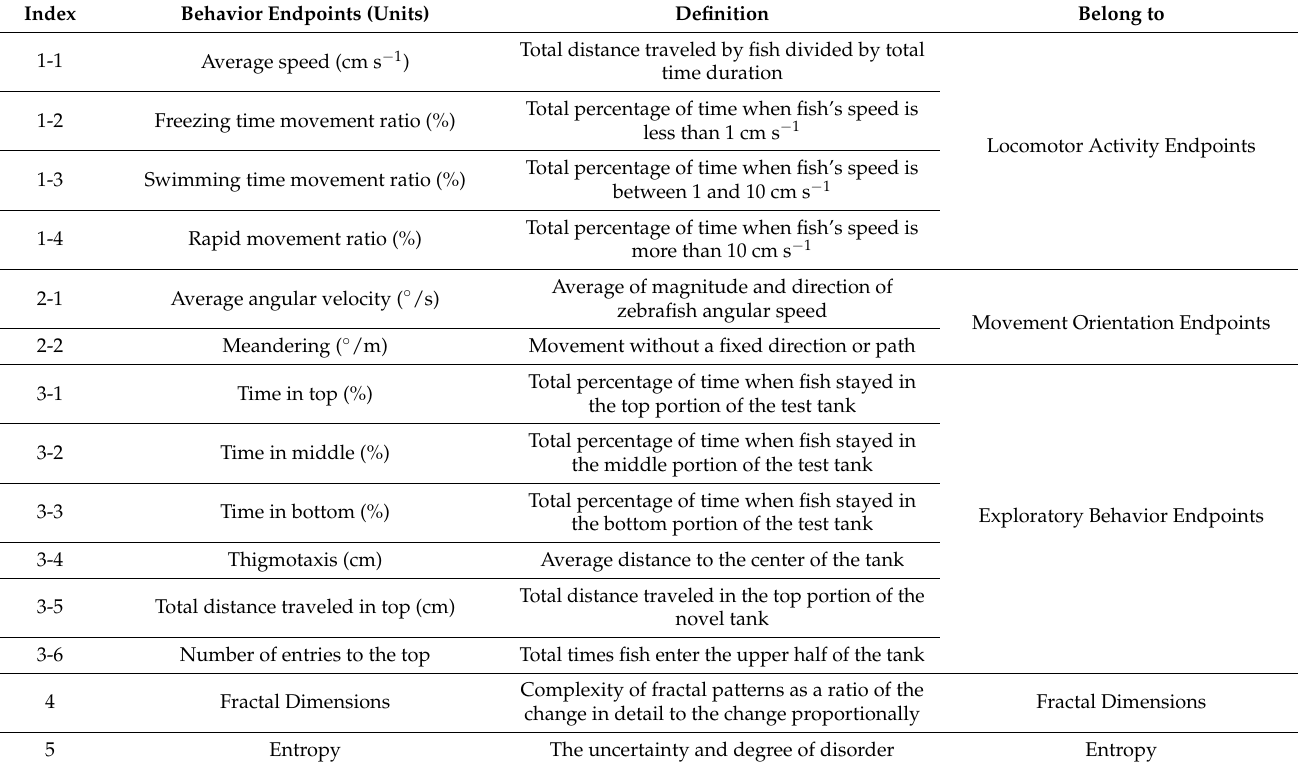
Table A1. Summary of fish behavioral endpoints measured in the 3D locomotion test conducted in this experiment.